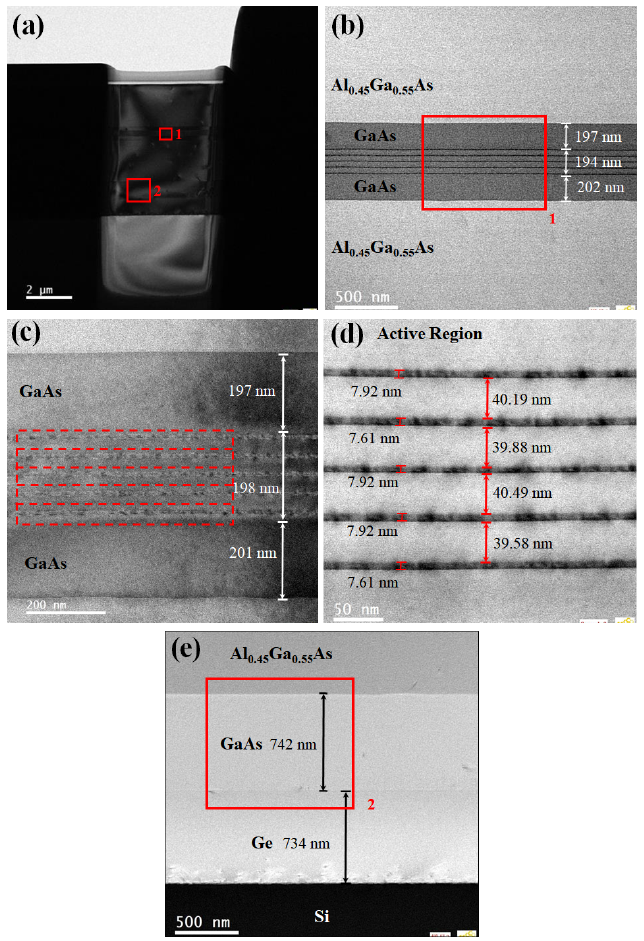
Figure 3. Cross-sectional TEM images of the film stack: ( a ) sample positioning; ( b ) active region; ( c , d ) enlarged image of position 1; ( e ) enlarged image of position 2.